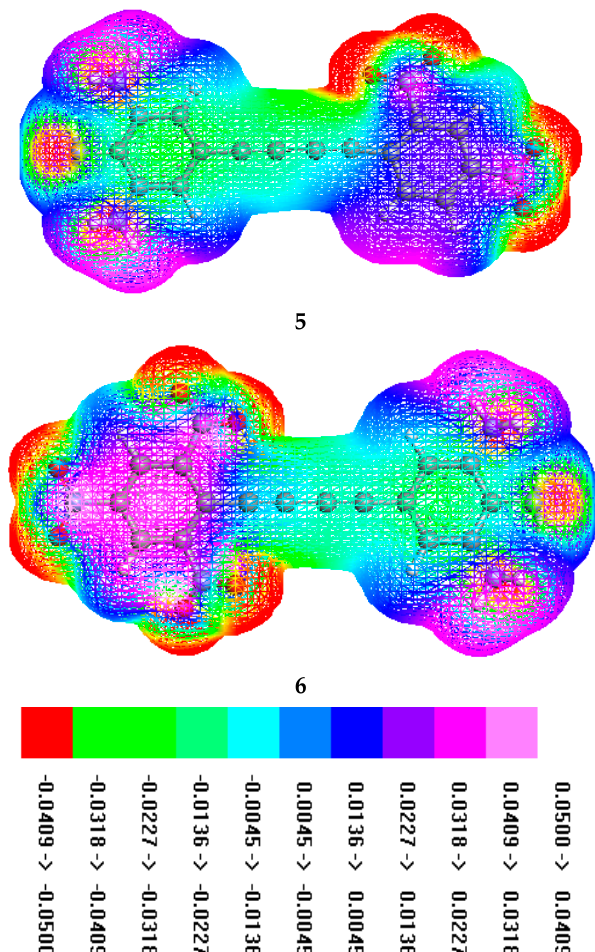
Figure 4. Diagrams and color scheme of the studied compounds R and 1 – 6 .